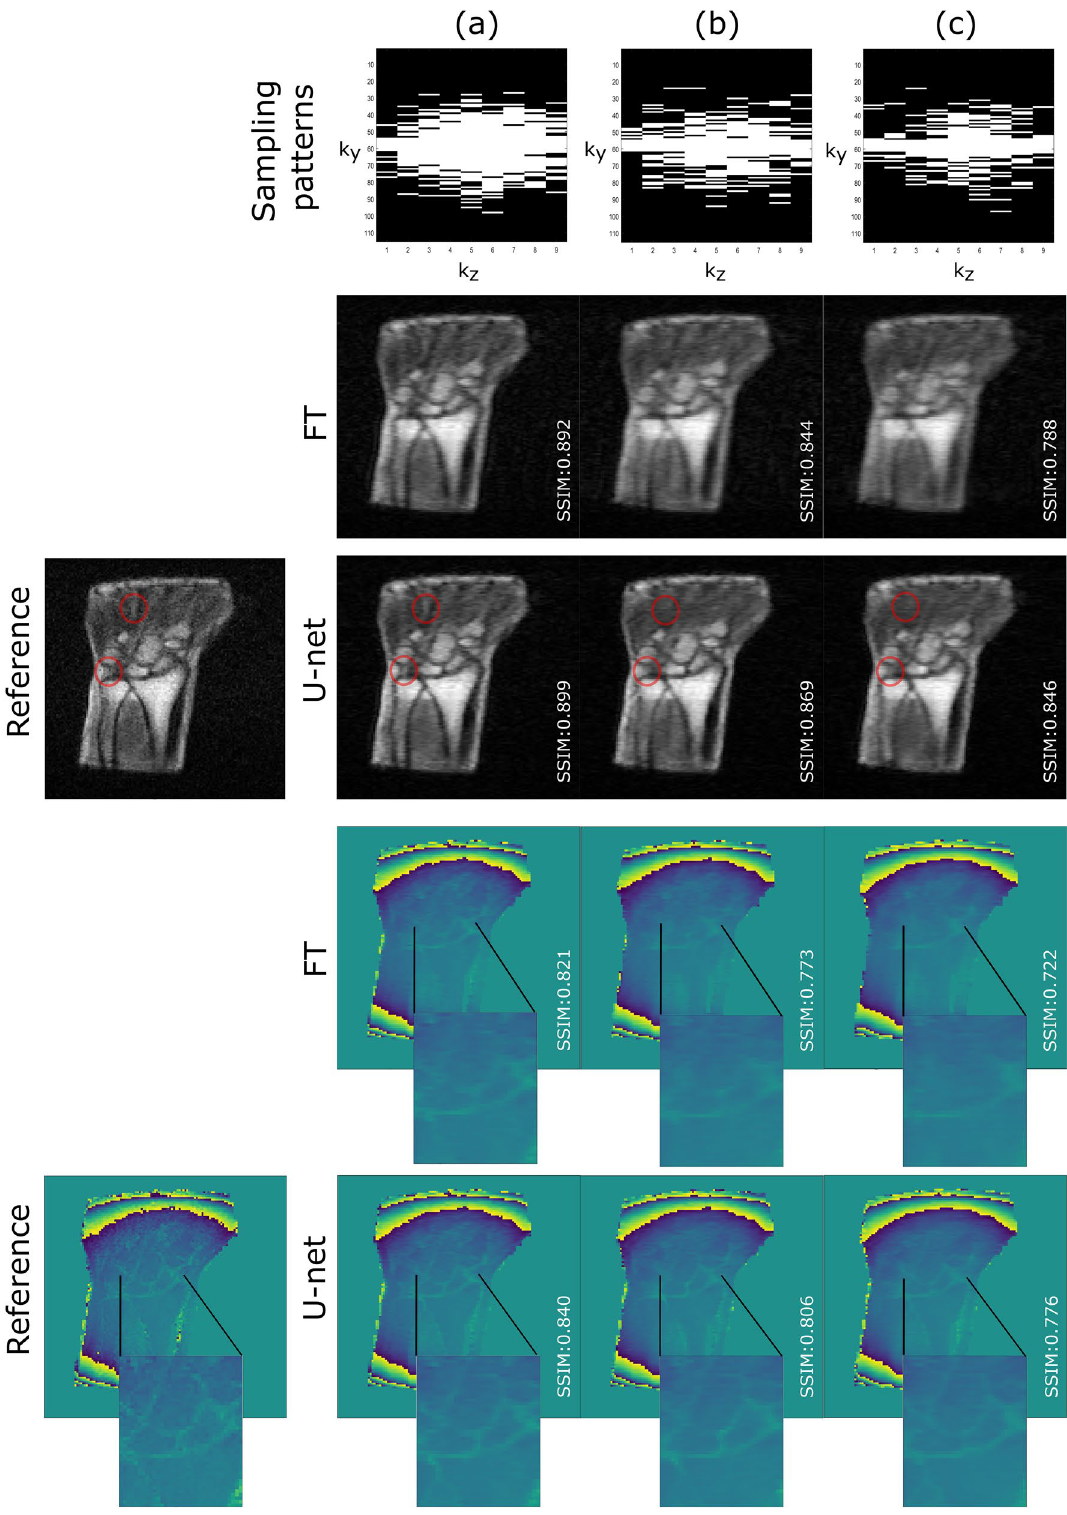
Figure 2. Model performance for different acceleration rates: ( a ) threefold, ( b ) fourfold and ( c ) fivefold. The red circles point out the missed details with higher acceleration rates in the magnitude